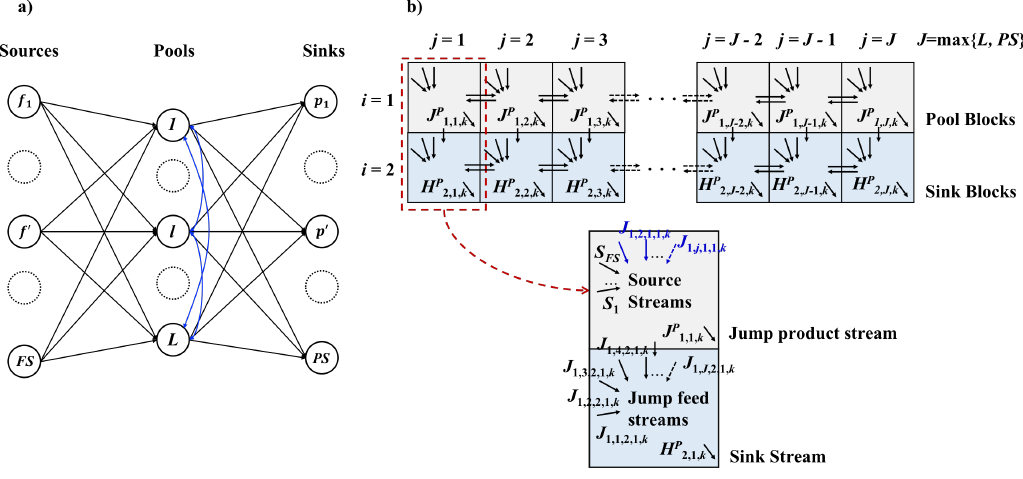
Figure 4. General superstructure for fuel gas network synthesis problem with intermediate pools: ( a ) General superstructure for fuel gas network with intermediate pools; ( b ) equivalent block